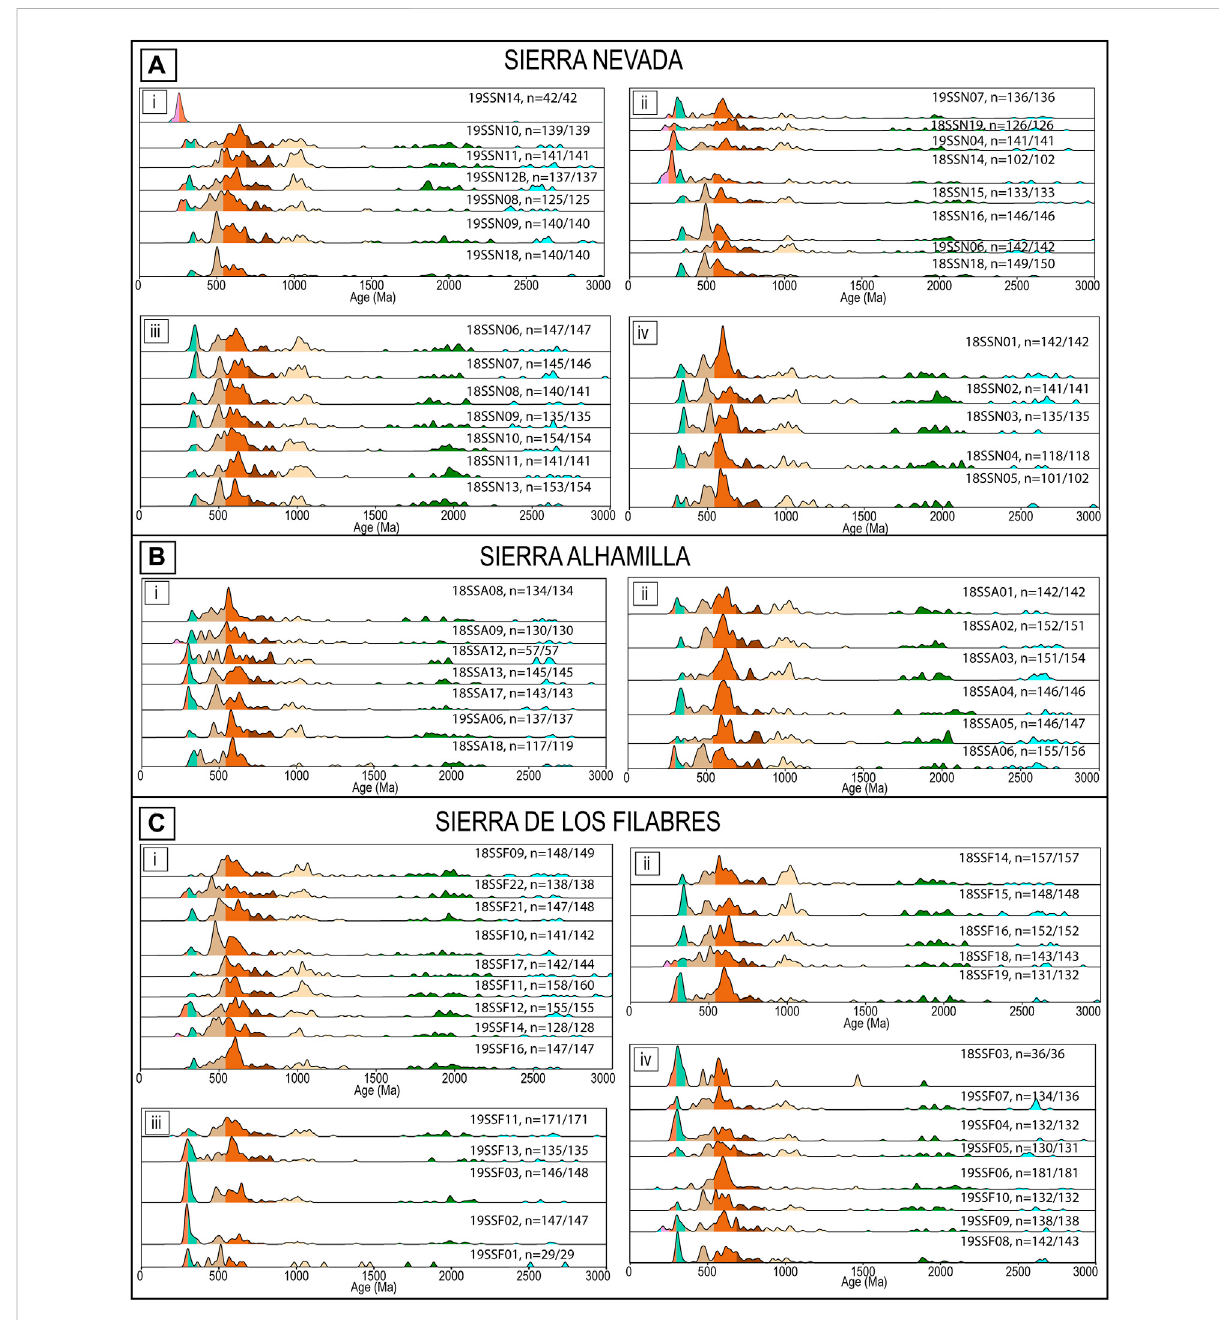
FIGURE 3 Kernel density estimate plots showing the detrital zircon spectrum of individual samples from the NFC organized by their structural position from (A) Sierra Nevada, (B) Sierra de Los Filabres, and (C) Sierra Alhamilla. Colors highlight thedifferent age modes(light blue: Jurassic, pink: Triassic, orange: Permian, light green: Carboniferous, light brown: Early Paleozoic, burnt orange: Ediacaran, dark brown: Early Neoproterozoic, beige: Mesoproterozoic(1,000 – 1,600 Ma),green:Paleoproterozoic,andcyan:Archean).N=#/#showsthenumberofzircongrainsappearedonthe KDE space vs. analyzed and passed the discordance fi